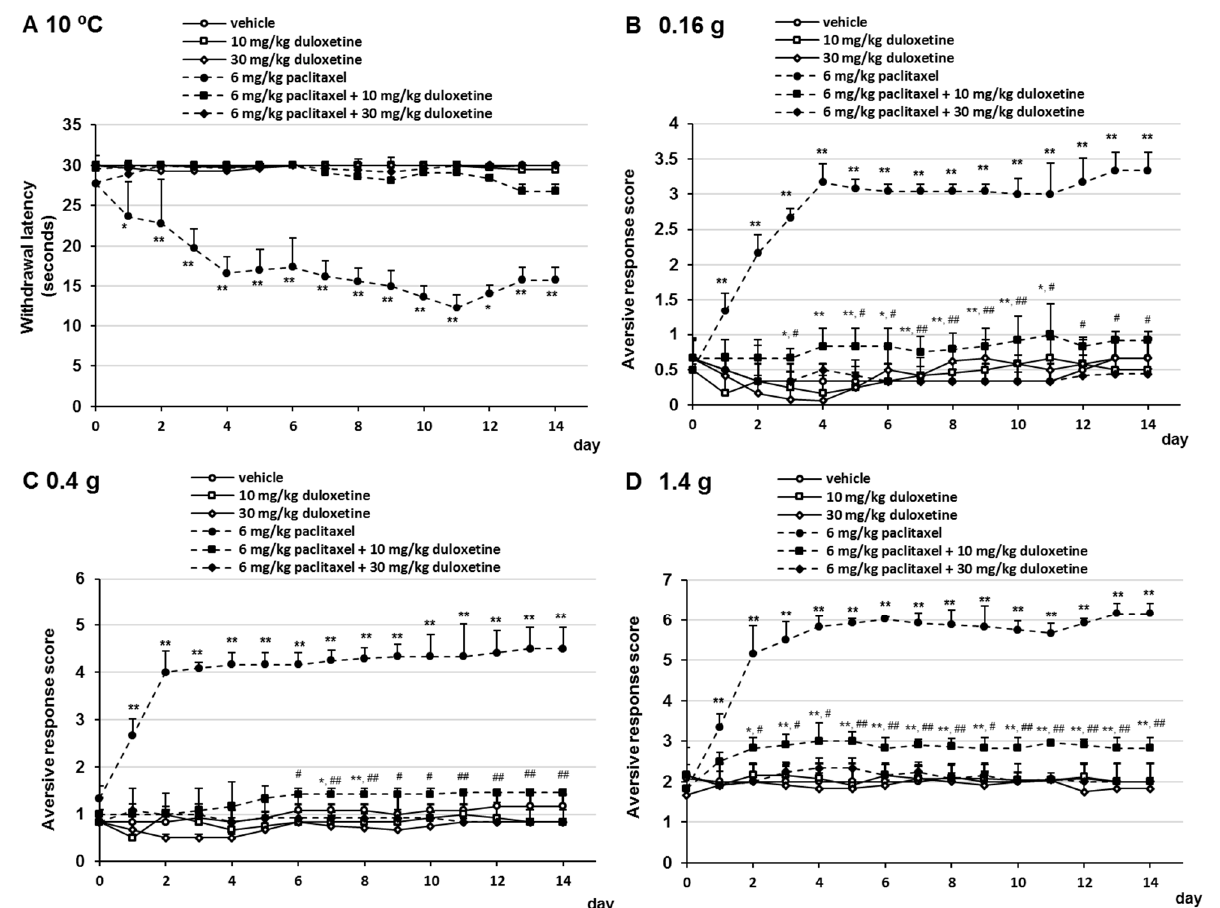
Figure 4. Inhibitory effect of duloxetine on paclitaxel-induced cold and mechanical allodynia in mice. Paclitaxel (6 mg/kg, i.p.) was administered on days 0 and 7, and duloxetine (10 or 30mg/kg, p.o.) was administered daily from days 0 to 14. ( A ) Withdrawal latencies, presented as means ± standard deviations (S.D.), represent the time taken by mice to withdraw their hind paws following cold stimulation (10 °C) ( n = 7 per group). * p < 0.05, ** p < 0.01 vs. vehicles (Shapiro–Wilk test and Kruskal–Wallis test followed by the Scheffe test). ( B – D ) The number of paw lifts elicited by five mechanical stimulations using von Frey filaments corresponding to ( B ) innocuous (0.16 g), ( C ) intermediate (0.4 g), and ( D ) noxious (1.4 g) bending forces. The aversive response score calculated based on two paw lifts ( n = 7 per group). * p < 0.05, ** p < 0.01 vs. vehicles, # p < 0.05, ## p < 0.01 vs. 6 mg/kg paclitaxel + 10 mg/kg duloxetine (Shapiro–Wilk test and one-way analysis of variance (ANOVA) with the Tukey test).